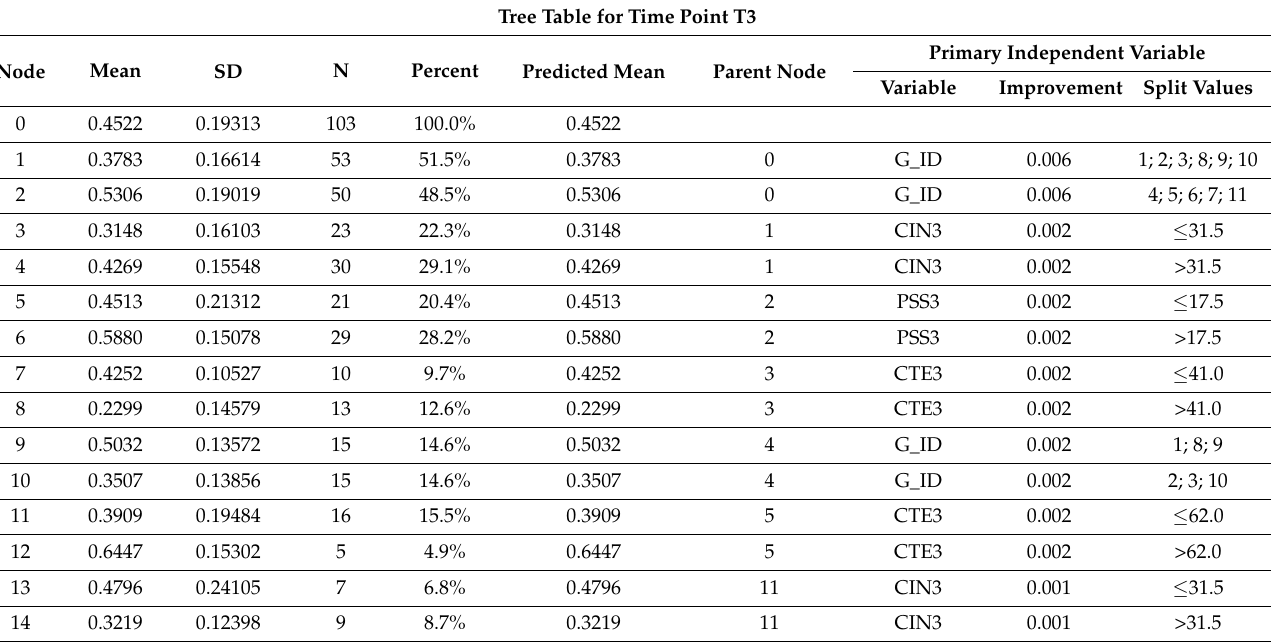
Table A5. Results description in table format for the designed C&RT Model 3. Tree Table for Time Point